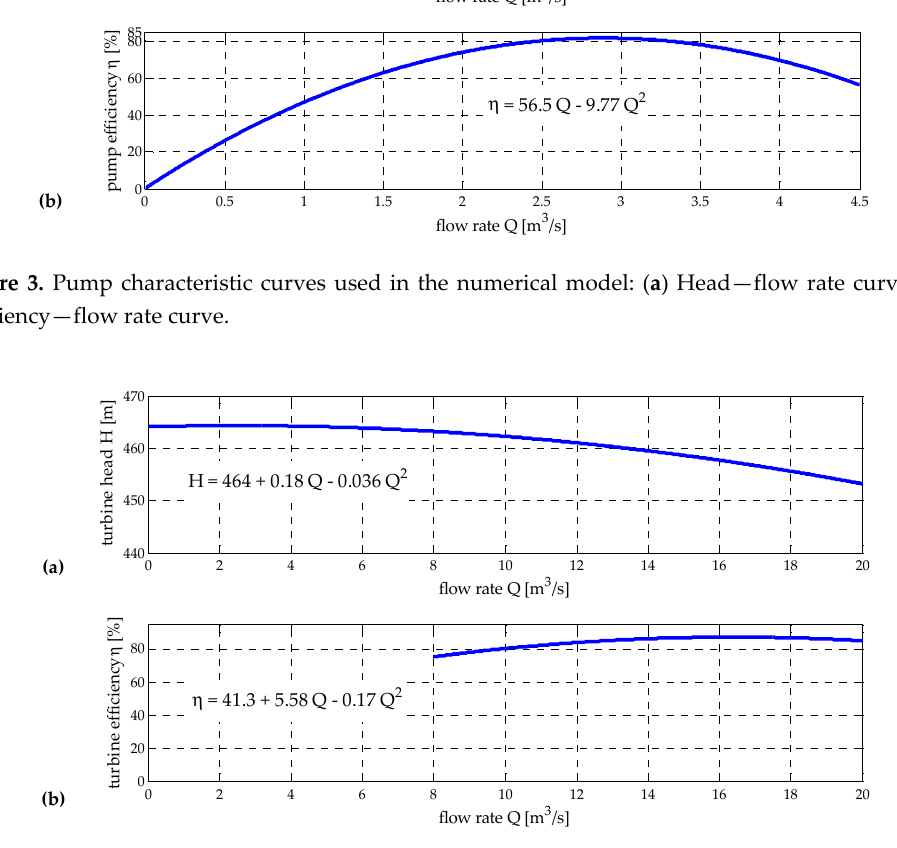
Figure 4. Turbine characteristic curves used in the numerical model: ( a ) Head—flow rate curve (attached to GPV in EPANET, as head losses—flow rate curve); ( b ) Efficiency—flow rate curve.